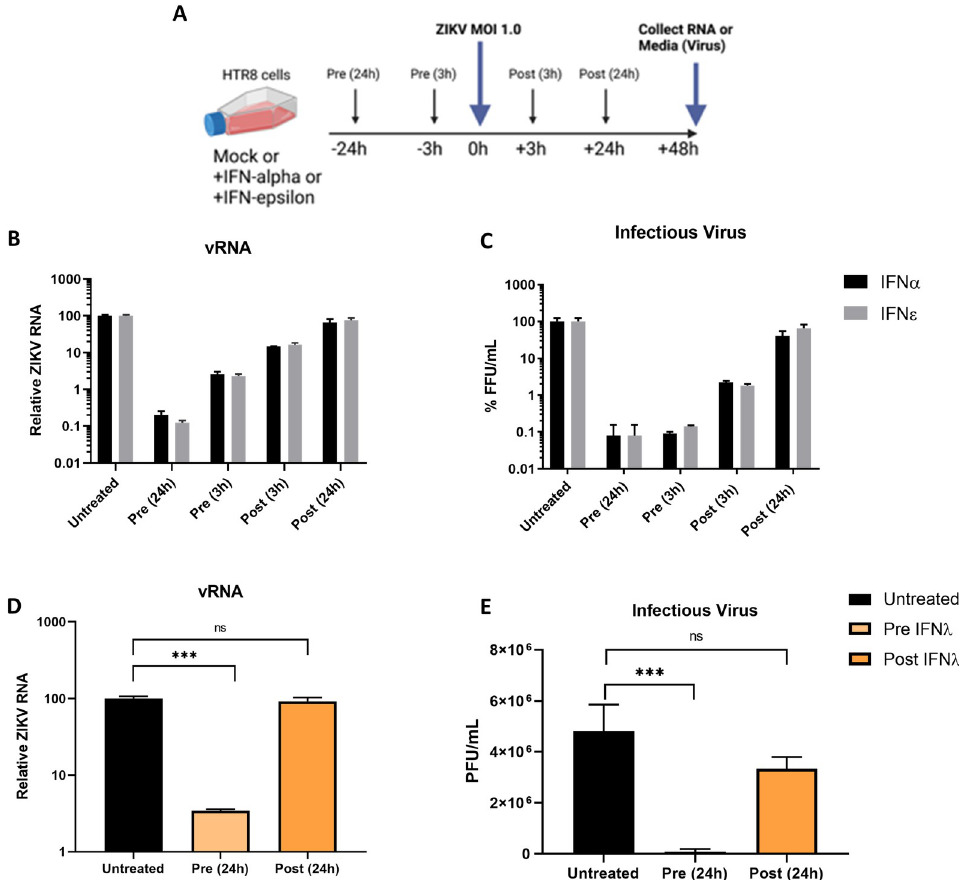
Fig 4. ZIKV evades type-I and III IFN antiviral activity post-infection. A) Timeline for IFN treatment regimes in HTR8 cells, arrows indicate media changes with either untreated media, IFN α , IFN ε , or viral inoculum. B & C)